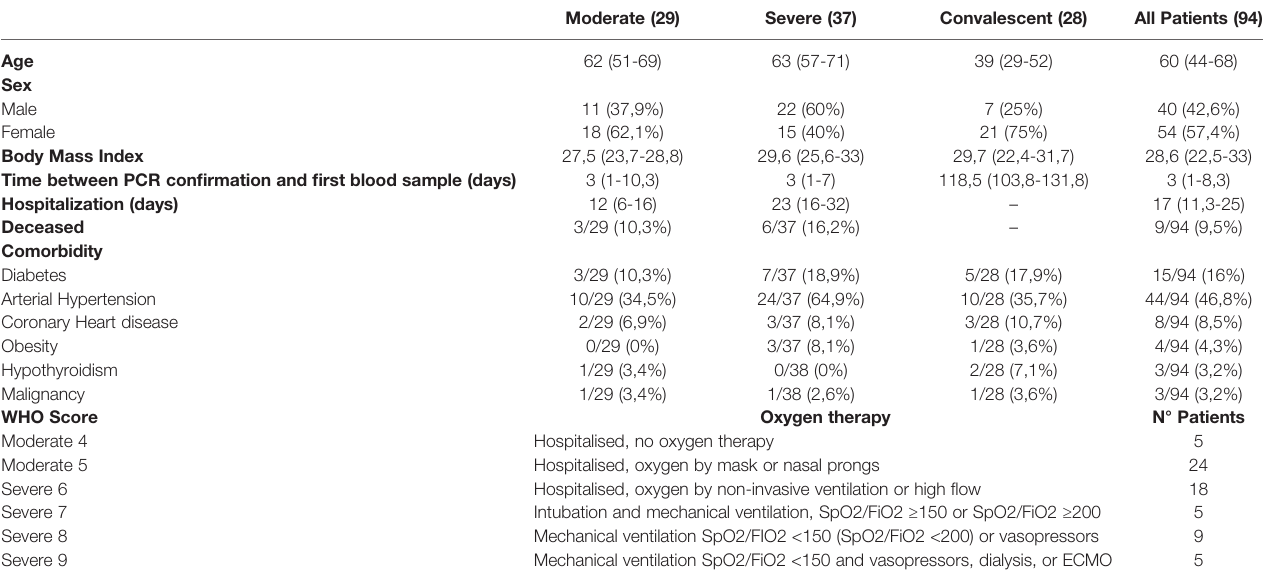
TABLE 1 | Clinical Characteristics. Data are listed as median